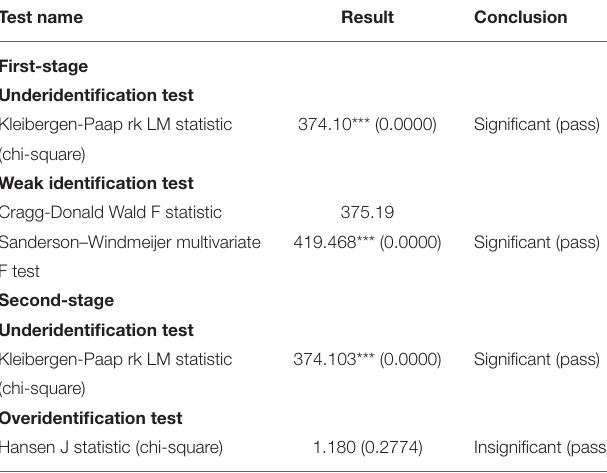
TABLE 6 | Results of reasonableness tests for instrumental variables. TABLE 7 | Estimates of urban–rural differences in the effects of the number of births on diabetes.